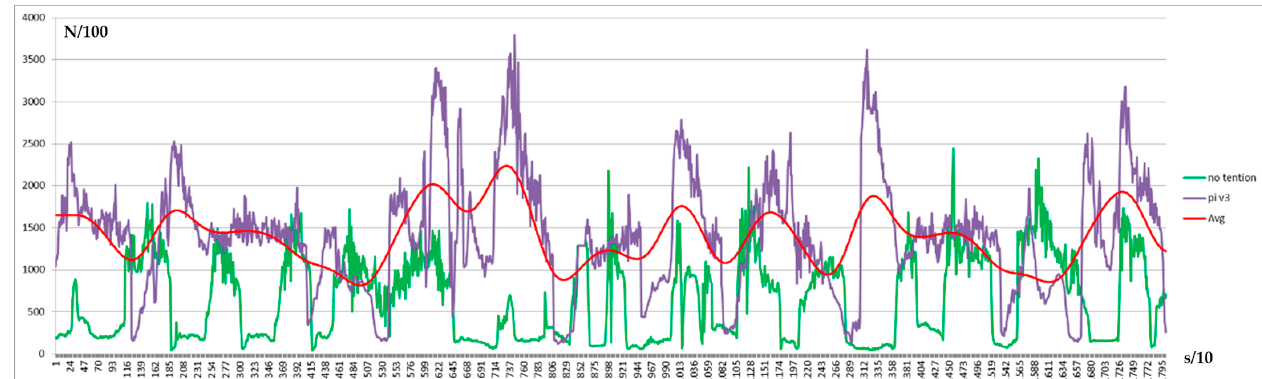
Figure 27. Complex matrix tensioning control results.